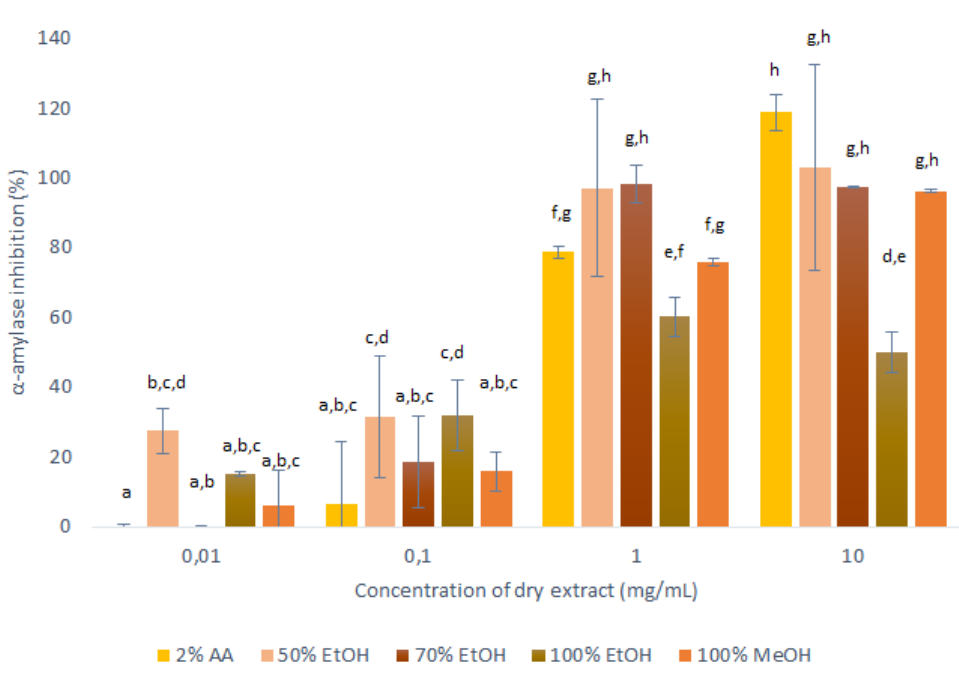
Figure 5. Anti- α -amylase activities of the dry matter from the primary extractions using conventional maceration with the di ff erent solvents (1:10 mass-to-liquid ratio; 25 ◦ C; 15 min), in terms of inhibition of α -amylase activity. Data are means ± standard deviation, and the di ff erent letters indicate significant di ff erences ( p < 0.05; ANOVA). AA, acetic acid; EtOH, ethanol; MeOH,